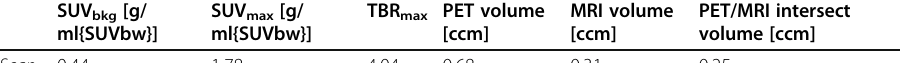
Table 3 Summary of static PET and volumetric PET/MRI cerebellar tumour data for scans 3 and 4 SUV bkg [g/